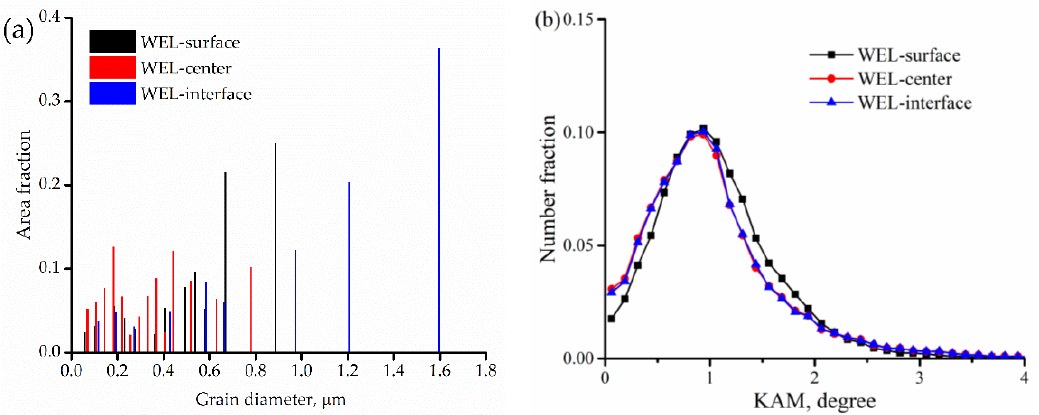
Figure 6. ( a ) Area fraction vs. grain diameter of the characterized TEM foils; ( b ) KAM plot of the characterized TEM foils, using 4th neighbor.